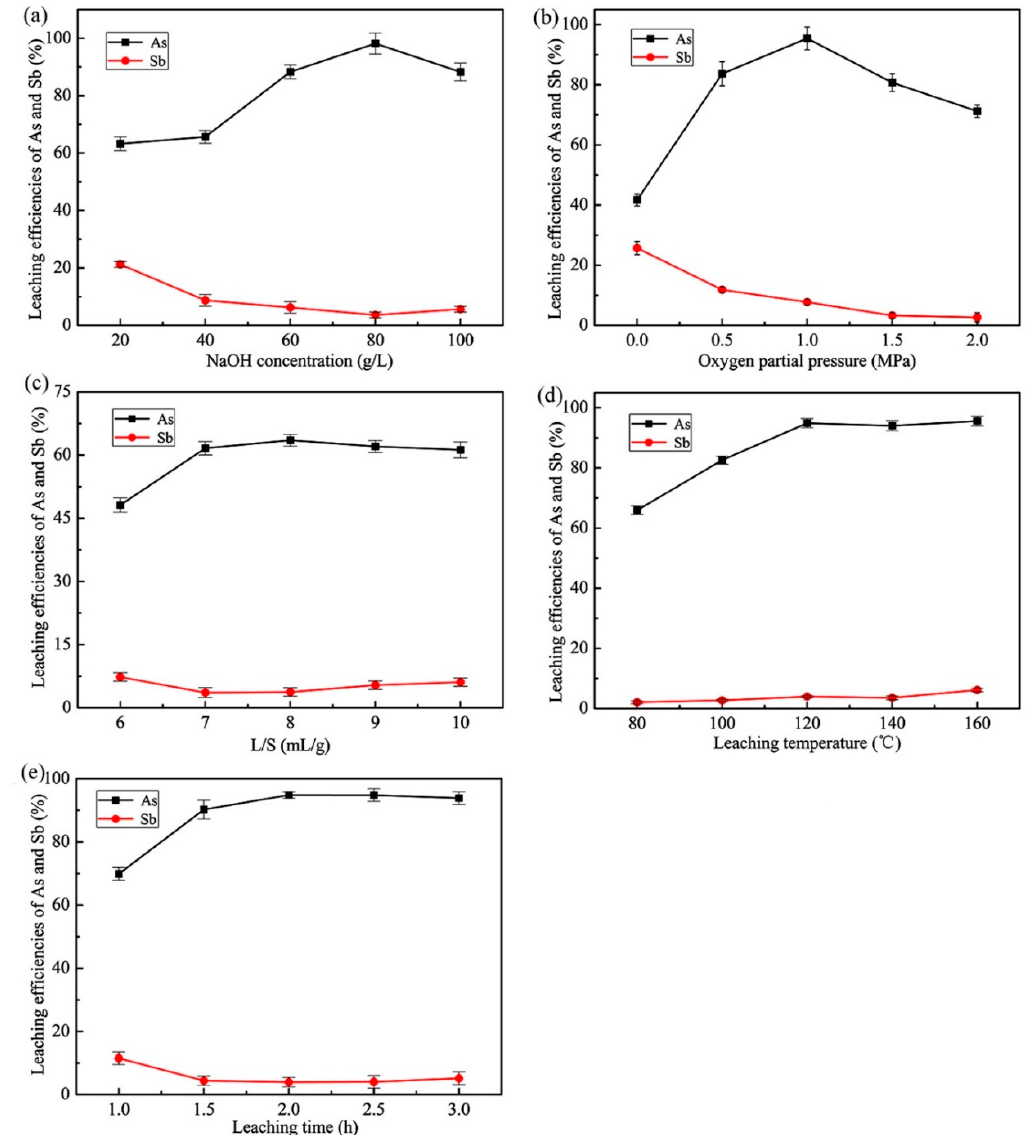
Figure 5. Effects of different APOL conditions on the extractions of As and Sb: ( a ) NaOH concentration (120 °C, L/S = 8 mL/g, 2.0 h, pO 2 = 1.0 MPa, 250 rpm), ( b ) oxygen partial pressure ([NaOH] = 80 g/L, L / S = 8 mL/g, 2.0 h, 120 °C, 250 rpm), ( c ) liquid-to-solid ratio ([NaOH] = 80 g/L, 120 °C, 2.0 h, pO 2 = 1.0 MPa, 250 rpm), ( d ) leaching temperature ([NaOH] = 80 g/L, L / S = 8 mL/g, 2.0 h, pO 2 = 1.0 MPa, 250 rpm), ( e ) leaching time ([NaOH] = 80 g/L, L / S = 8 mL/g, 120 °C, pO 2 = 1.0 MPa, 250 rpm).